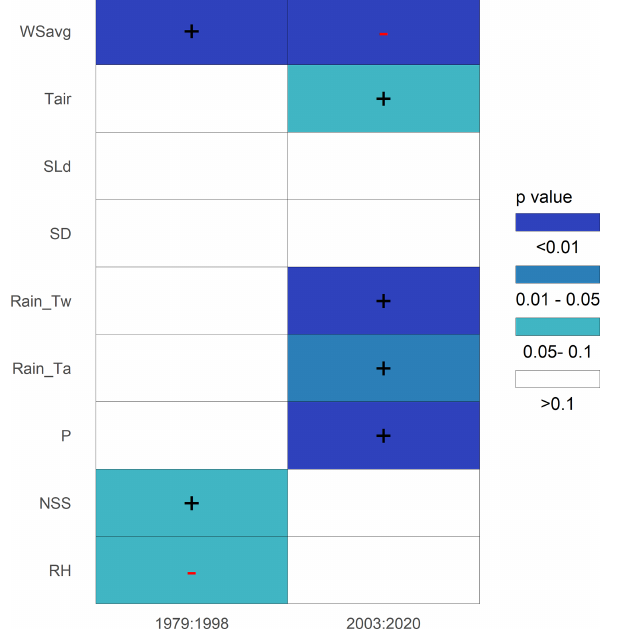
Figure 8. The avalanche occurrence path distribution per orienta- tion for slab avalanches. The radial axis represents the avalanche proportion for each cardinal